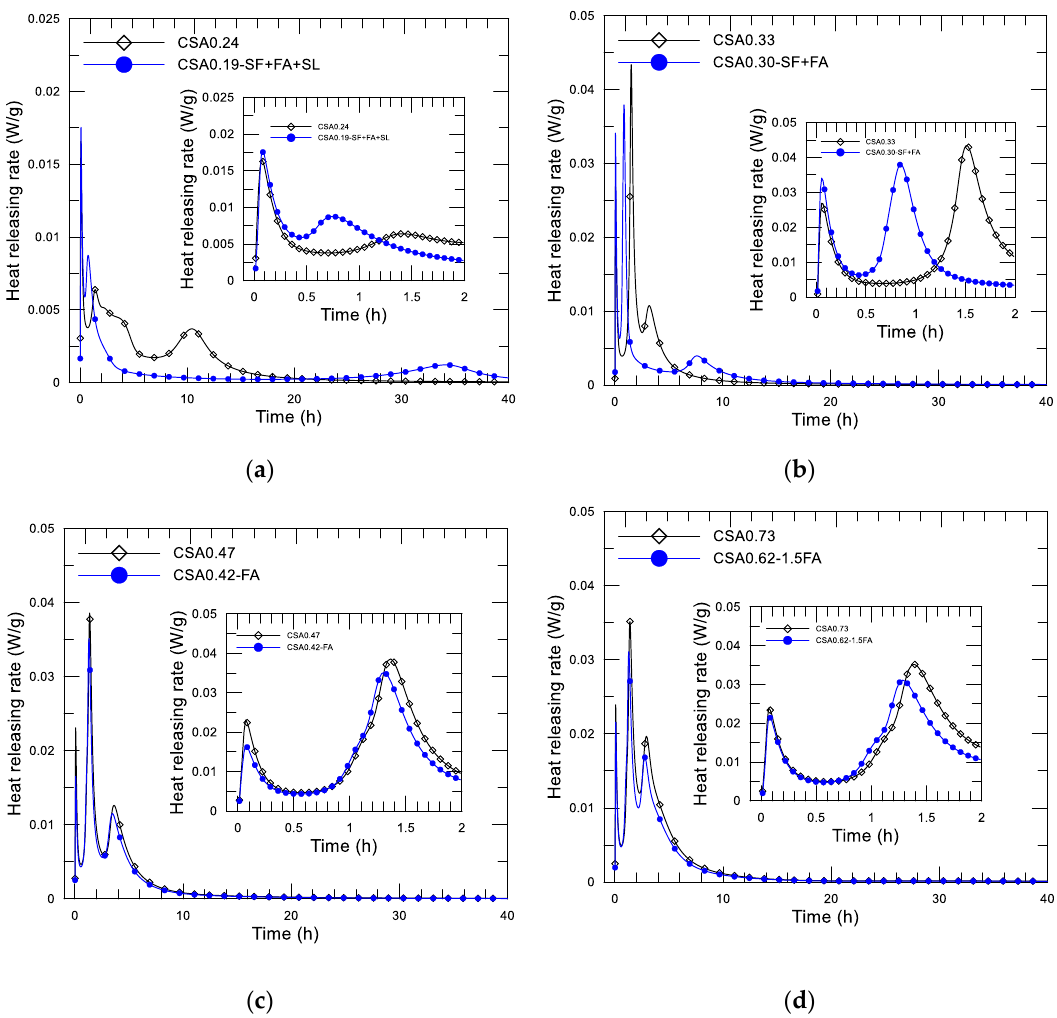
Figure 11. Heat-releasing rate of CSA pastes with effect of addition of SCMs and w/c, ( a ) CSA0.24, CSA0.19-SF+FA+SL, ( b ) CSA0.33, CSA0.30-SF+FA, ( c ) CSA0.47, CSA0.42-FA, ( d ) CSA0.73, CSA0.62-1.5FA.